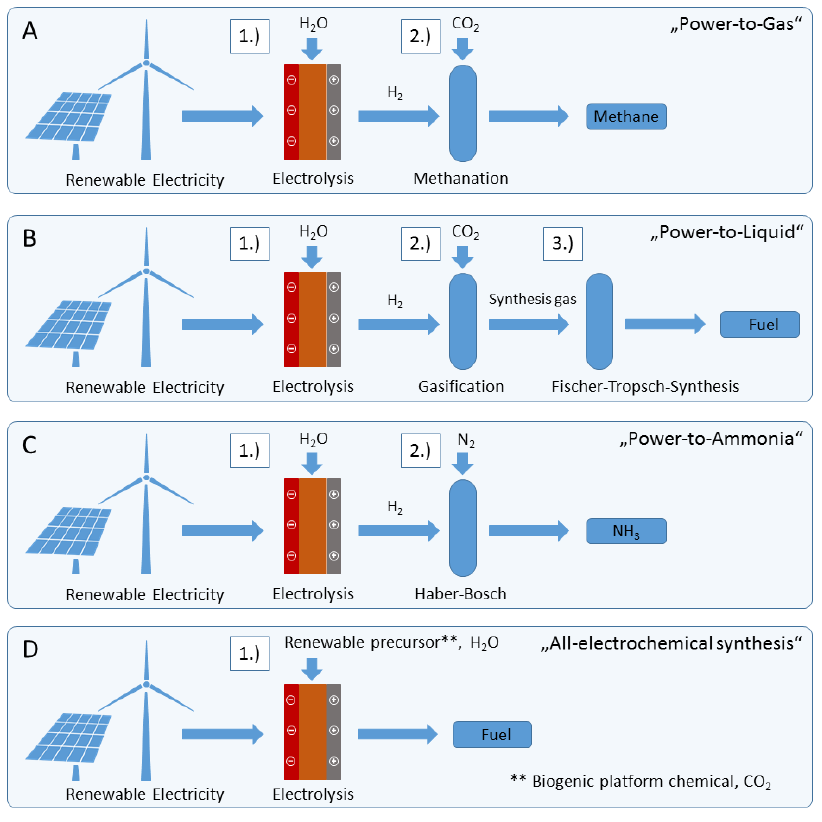
Figure 1. Schematic illustration of the described “power-to-X” technologies: ( A ) Power-to-Gas; ( B ) Power-to-Liquid; ( C ) Power-to-Ammonia; ( D ) All-electrochemical